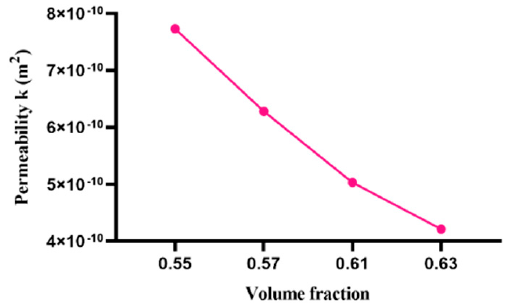
Figure 9. Effect of volume fraction on fluid permeability.